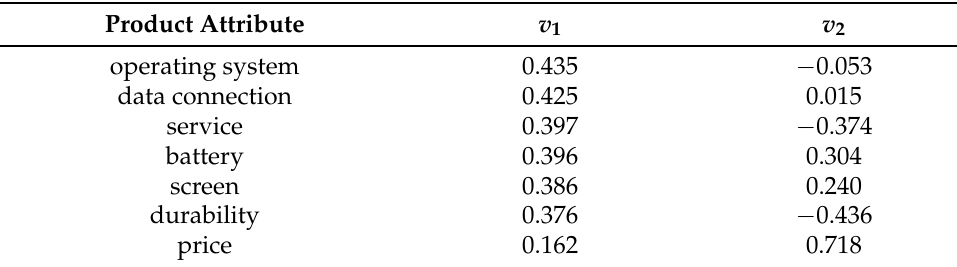
Table 5. Eigenvector for the first two